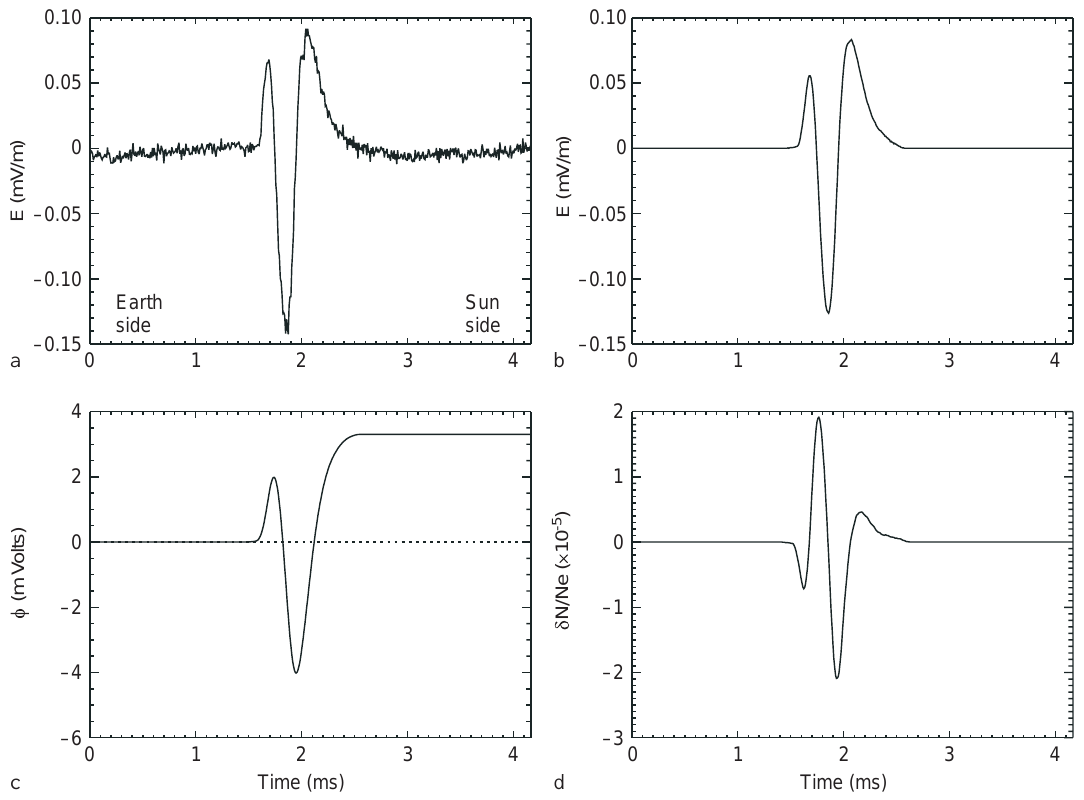
Fig. 6a–d. For the central double layer in Fig. 1f (between 8 and 9 ms), time profile of: a the measured electric field (positive if directed towards the Earth); b the electric field smoothed over 10 points; c the corresponding potential profile; d the charge separation d N (cid:136) N p (cid:255) N e